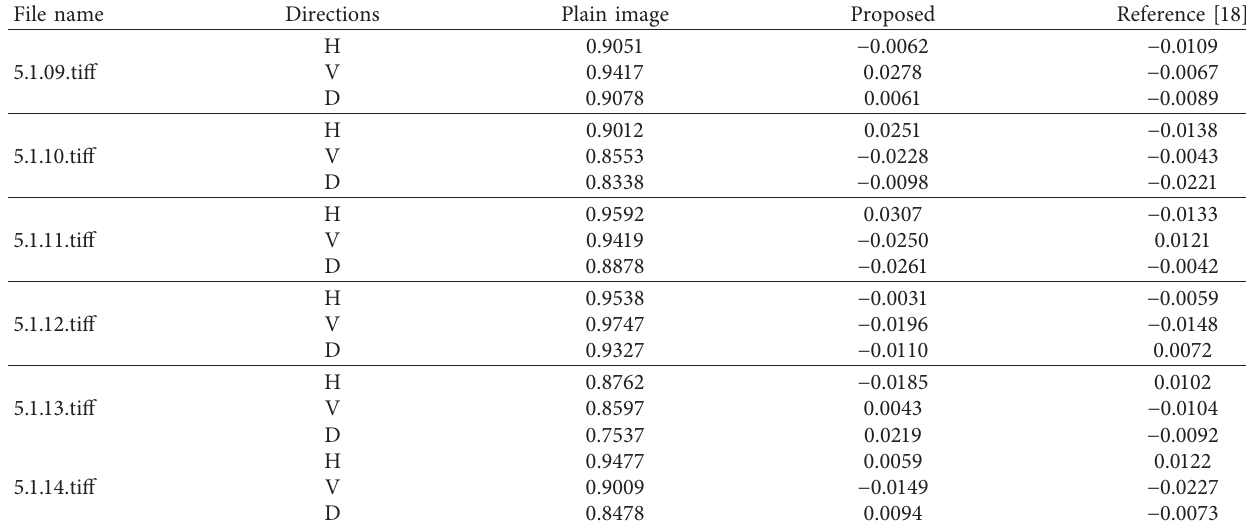
Figure 8: Correlation analysis: (a, c, e) the pixel sequence distributions of the plain image 5.1.12.tiff in the horizontal, vertical, and diagonal directions, respectively; (b, d, f) the pixel distributions of the corresponding encrypted image in the horizontal, vertical, and diagonal directions. Table 2: Correlation analysis.